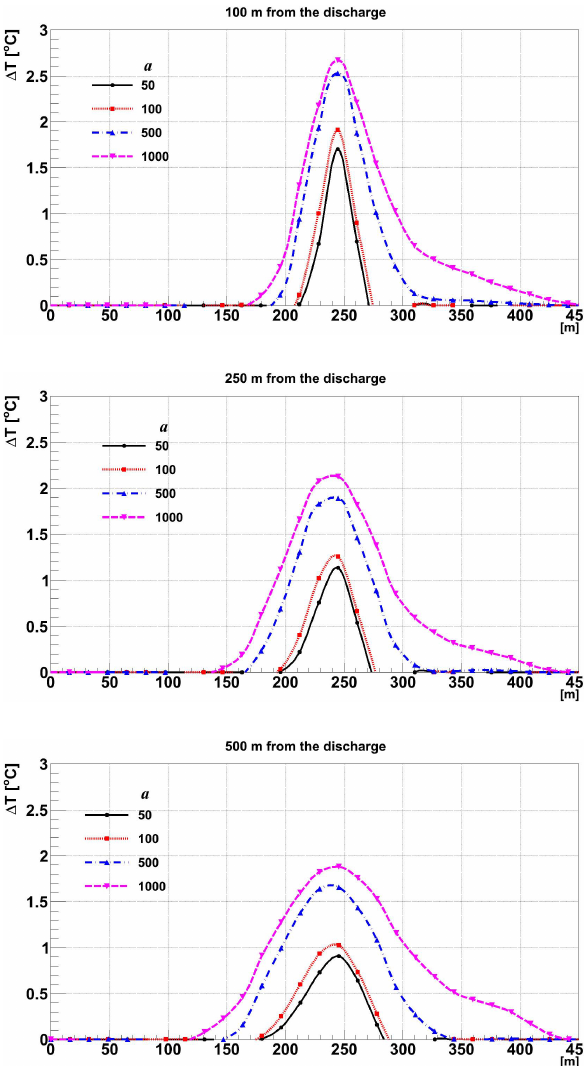
Fig. 7. Temperature distribution in case of continuous discharge of 14m 3 s − 1 of warm water at point Z 1 =(1850, 800) for different values of dimensionless coefficient across the cross-sections located at 100, 250 and 500m from the discharge.